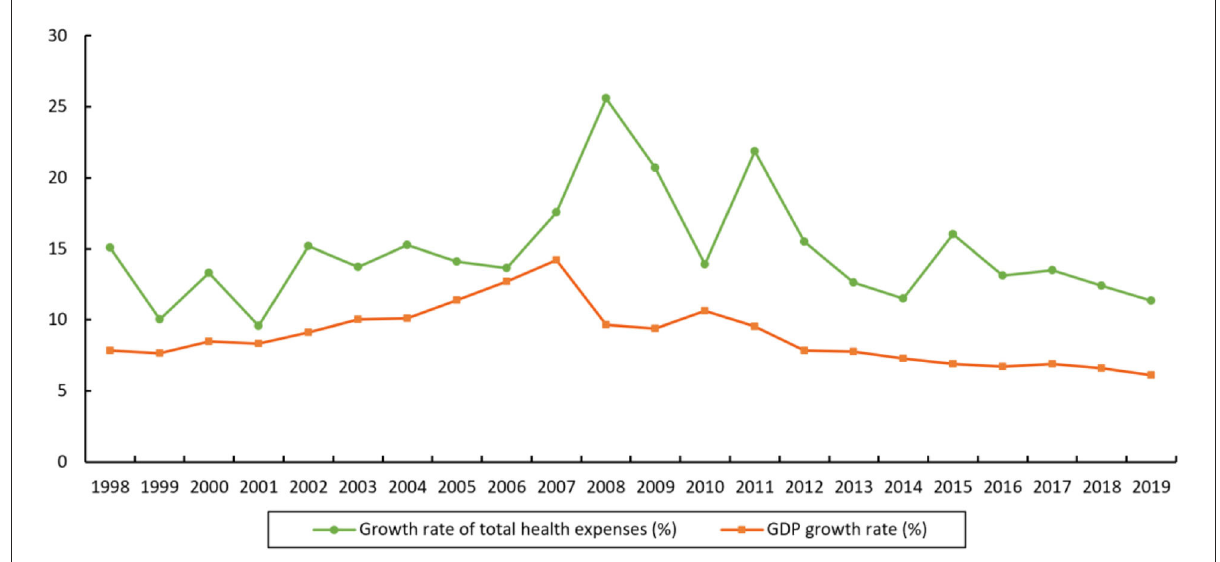
FIGURE1 Growth rate of total medical expenses and GDP growth rate in China during 1998-2019. Data sources: China Health and Health Statistical Yearbook, China Statistical